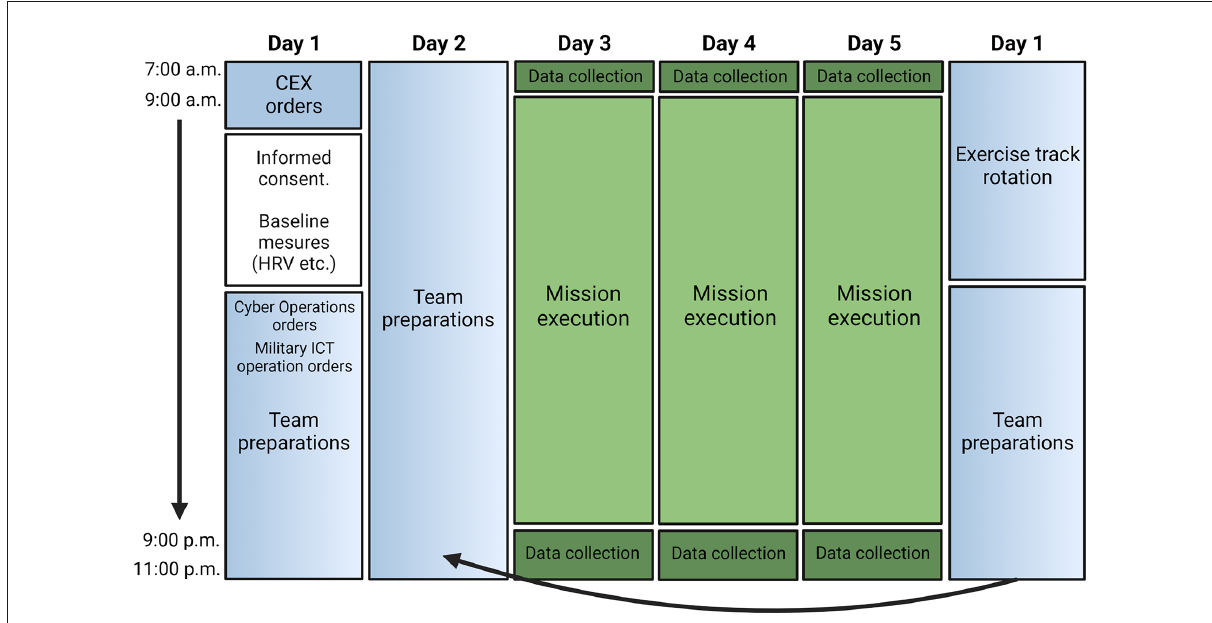
FIGURE3 Overview of the study and the cyber engineering exercise. CEX, Cyber engineering exercise; HRV, Heart rate variability.